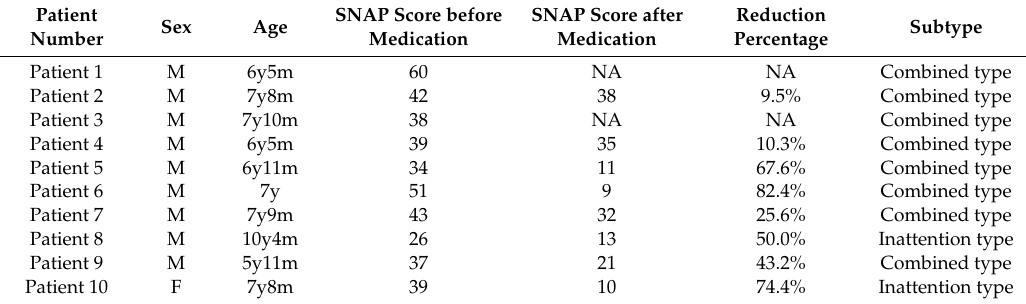
Table 1. Demographic data of patients with attention-deficit hyperactivity disorder (ADHD).